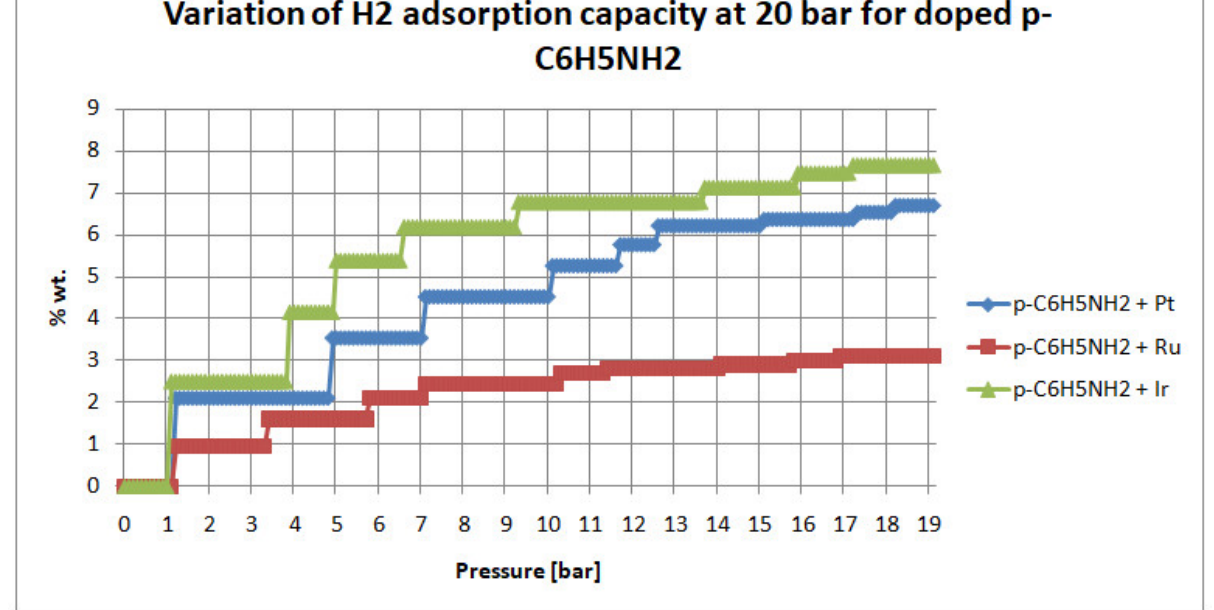
Figure 9. Metal-doped p-C 6 H 5 NH 2 H 2 -adsorption-capacity determination at 20 bar.